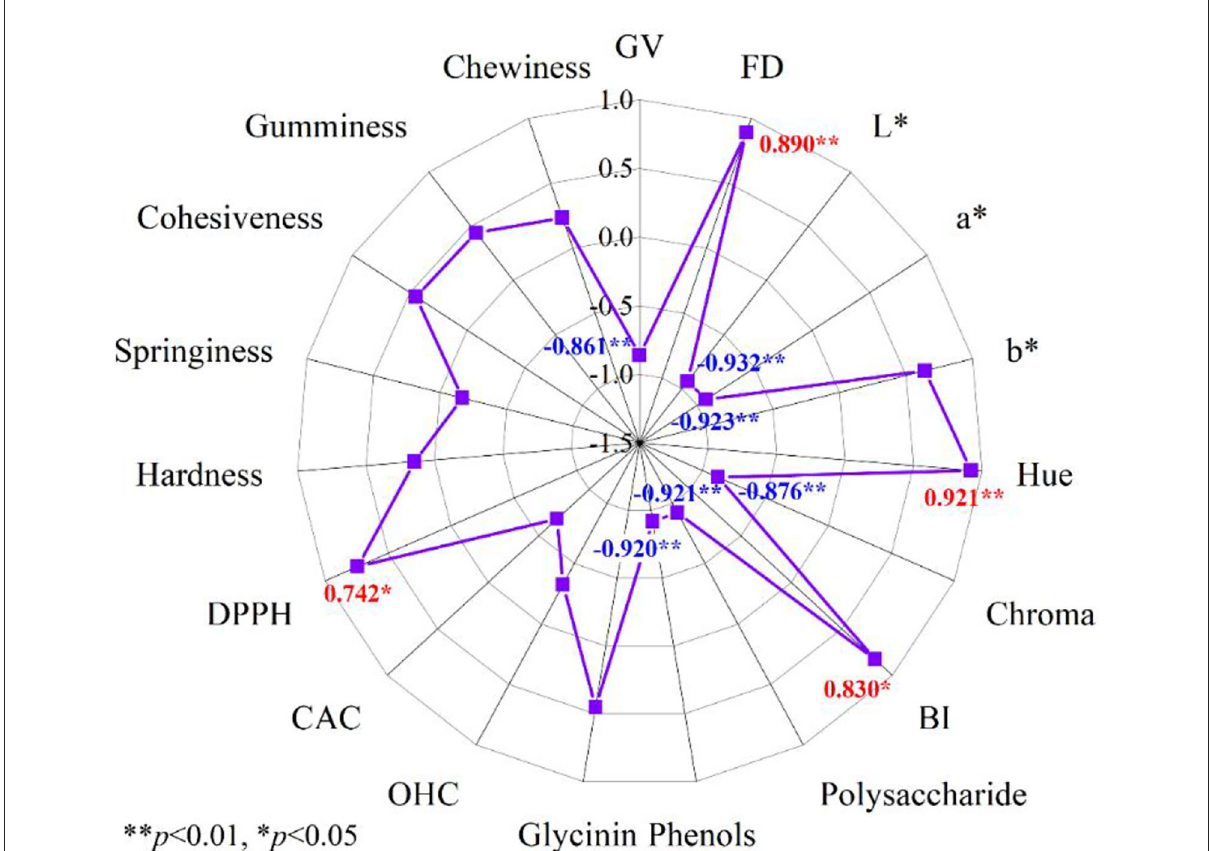
FIGURE7 Correlation of steam explosion intensity and morphological and physicochemical properties of soybean meal. OHC, oil-holding capacity; CAC, cholesterol absorbing capacity; DPPH, 2,2-diphenylpicrylhydrazyl (DPPH) radical scavenging activity; GV, gray values; FD, fractal dimension; BI, browning